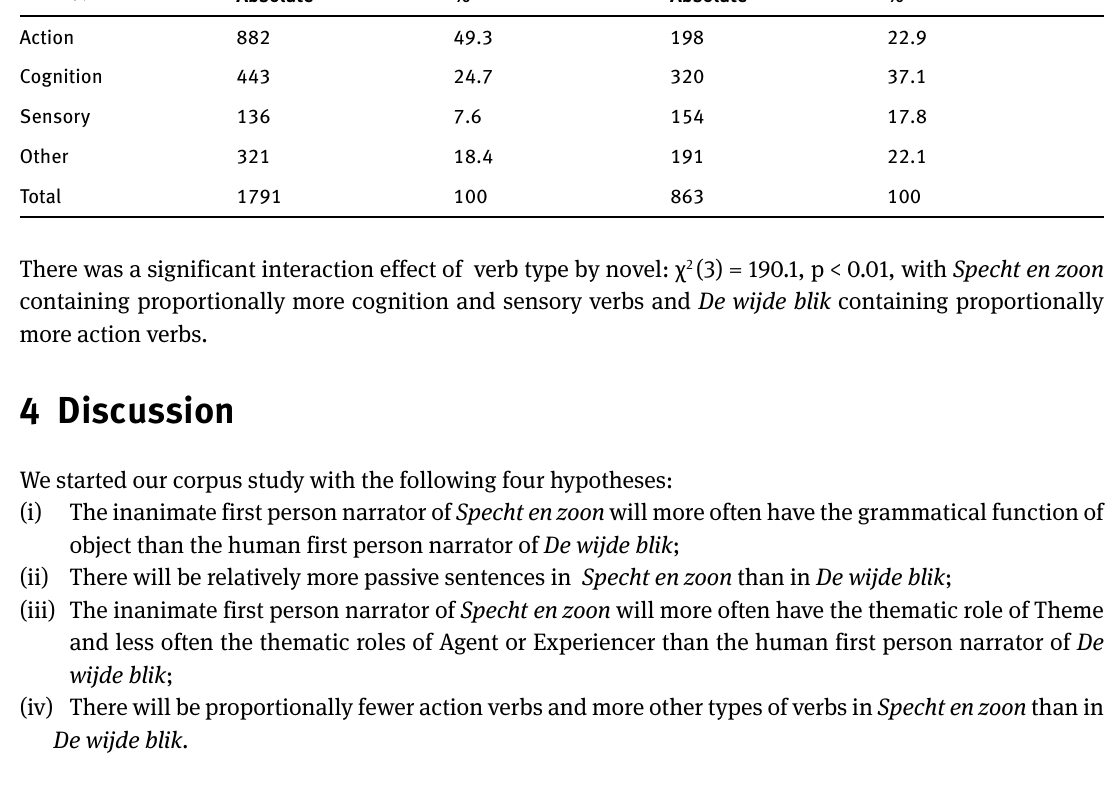
Table 3: Verb type associated with the first person narrator by novel De wijde blik Specht en zoon Verb Type Absolute % Absolute % Action 882 49.3